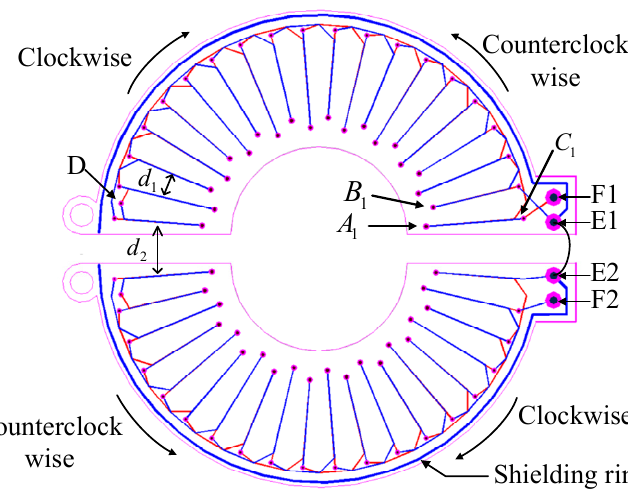
Figure 5. Schematic diagram of winding mode of open-ended PCB Rogowski coil.